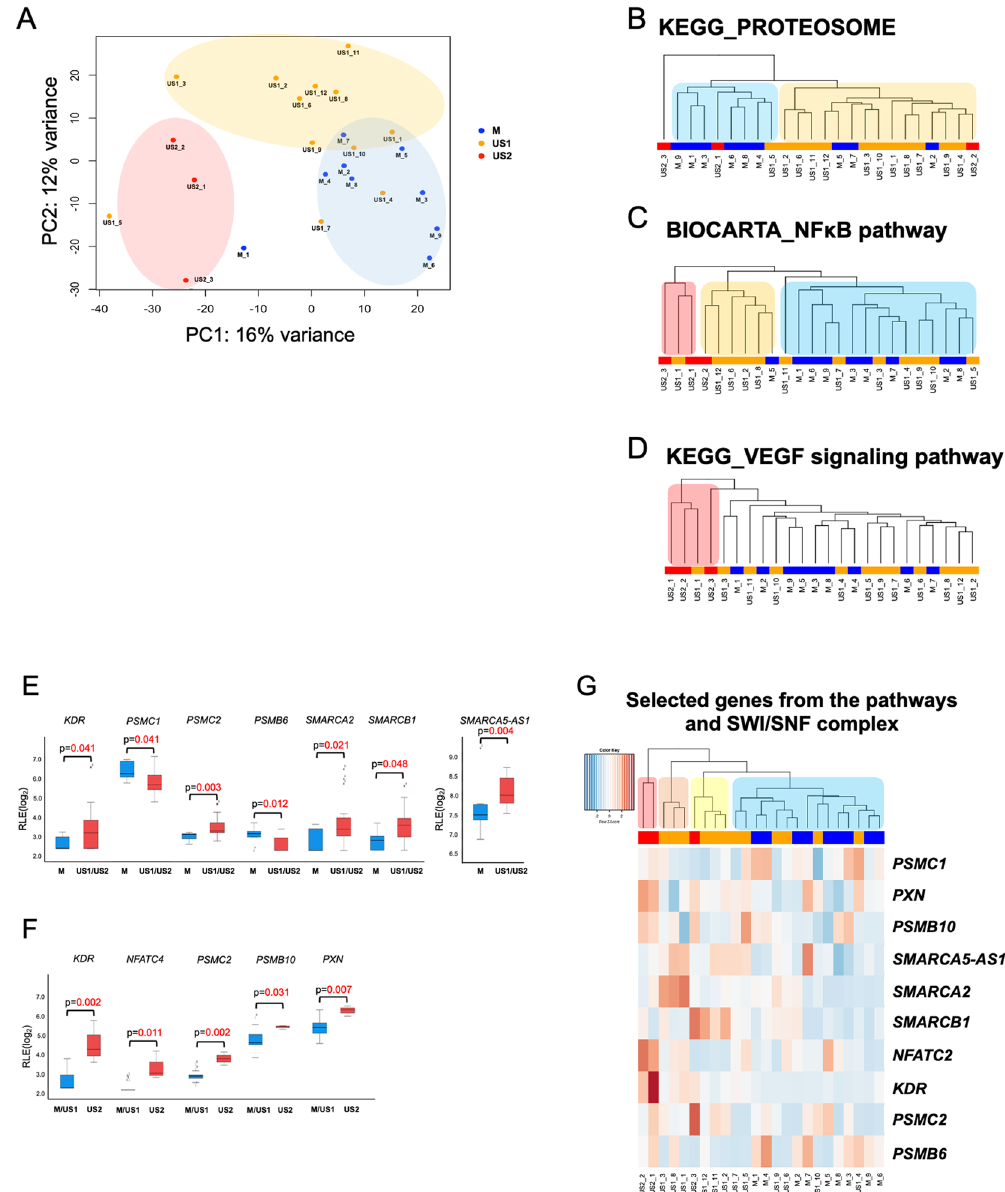
Figure 3. ( A ) PCA of gene expression profiles. Each case of so-called MFS (blue), US1 (orange), and US2 (red) is shown as a dot of a different color. Plots were clustered into the so-called MFS (blue frame), US1 (orange frame), and US2 (red frame) groups. ( B ), ( C ), and ( D ) Hierarchical clustering analysis for the KEGG_ PROTEASOME, BIOCARTA_NFκB, and KEGG_VEGF_signaling pathways, respectively. Cases of the so-called MFS, US1, and US2 clusters are shown in blue, yellow, and red boxes, respectively, alongside the case numbers. The identified clusters are shown using different colors (See text). Each complete result, with a heat map and the names of the individual gene in the pathway, is provided in Supplementary Figure S1. M, so-called MFS. ( E ) Box-and-whisker diagrams, analysis of genes in the PROTEASOME, NFκB , and VEGF signaling pathways and SWI/SNF complex-related sarcoma genes, which showed significantly different expression levels between the so-called MFS and US1/US2 (so-called US) groups, and ( F ) comparison between the so-called MFS/US1 and US2 (prominent sickle-shaped blood vessels) are shown. ( G ) Twelve genes with significant differences were used for the hierarchical clustering analysis. Cases of the so-called MFS, US1, and US2 groups are shown using blue, yellow, and red boxes, respectively, at the top of the heat map. Further, the clusters identified are shown using different colors (See text). The heat map shows the degree of change in the expression level of each gene according to the color range shown in the histogram (upper left). M, so-called